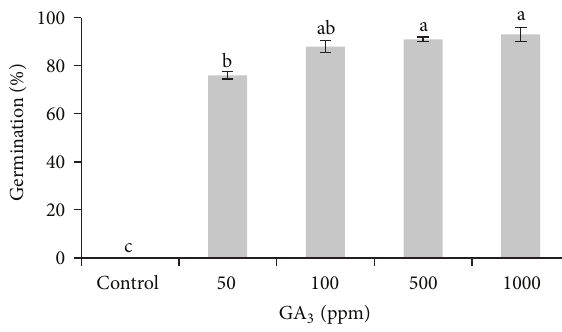
Figure 5: Germination percentages of Gentiana lutea var. aurantiaca seeds using different GA 3 doses (50, 100, 500, and 1000ppm) and control at the end of the test of 90 days of germination. Bars with different letters are significantly different ( 𝑃 = 0.05 ) according to LSD.